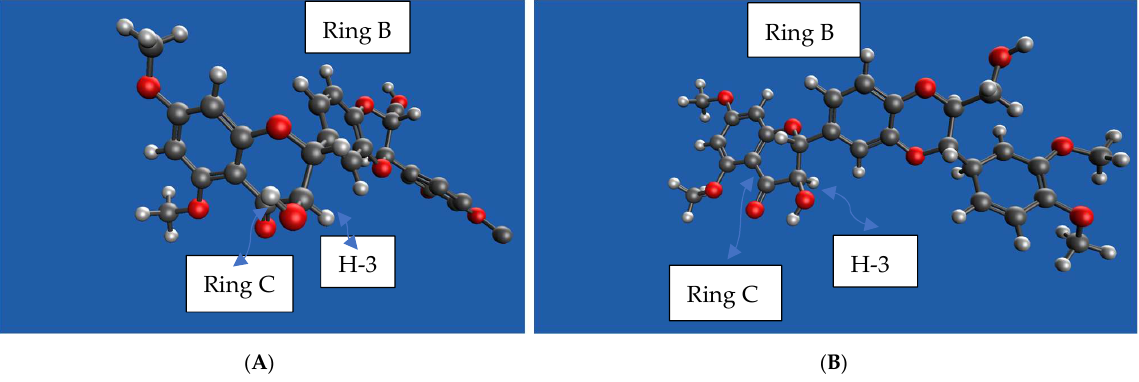
Figure 9. ( A – B ) 3D models for 5A and 5B . The models were created with IQmol. Red ball represents oxygen (O); black, carbon (C); grey, hygrogen (H). Table 6. Antiproliferative activity of optically enriched trimethylsilybins. The antiproliferative potency and selectivity of ten pairs of diastereomers were eval- uated on AR-positive (LNCaP and 22Rv1) and AR-negative (PC-3 and DU145) human prostate cancer cell lines. The IC 50 values are summarized in Table 6 and reveal that (10 R ,11 R ) derivatives (silybin A series) possess a significantly greater antiproliferative potency and higher selectivity than (10 S ,11S) derivatives (silybin B series) towards LNCaP prostate cancer cell lines. Derivatives 8A and 41A were identified as the optimal derivatives with an IC 50 value of 0.07 µ M in the LNCaP cell model. However, these derivatives cannot suppress 22Rv1 prostate cancer cell proliferation up to a 10 µ M concentration, revealing that the derivatives of 5,7,20- O -trimethylsilybin very likely bind to the ligand-binding domain on AR to exhibit antiproliferative activity in LNCaP